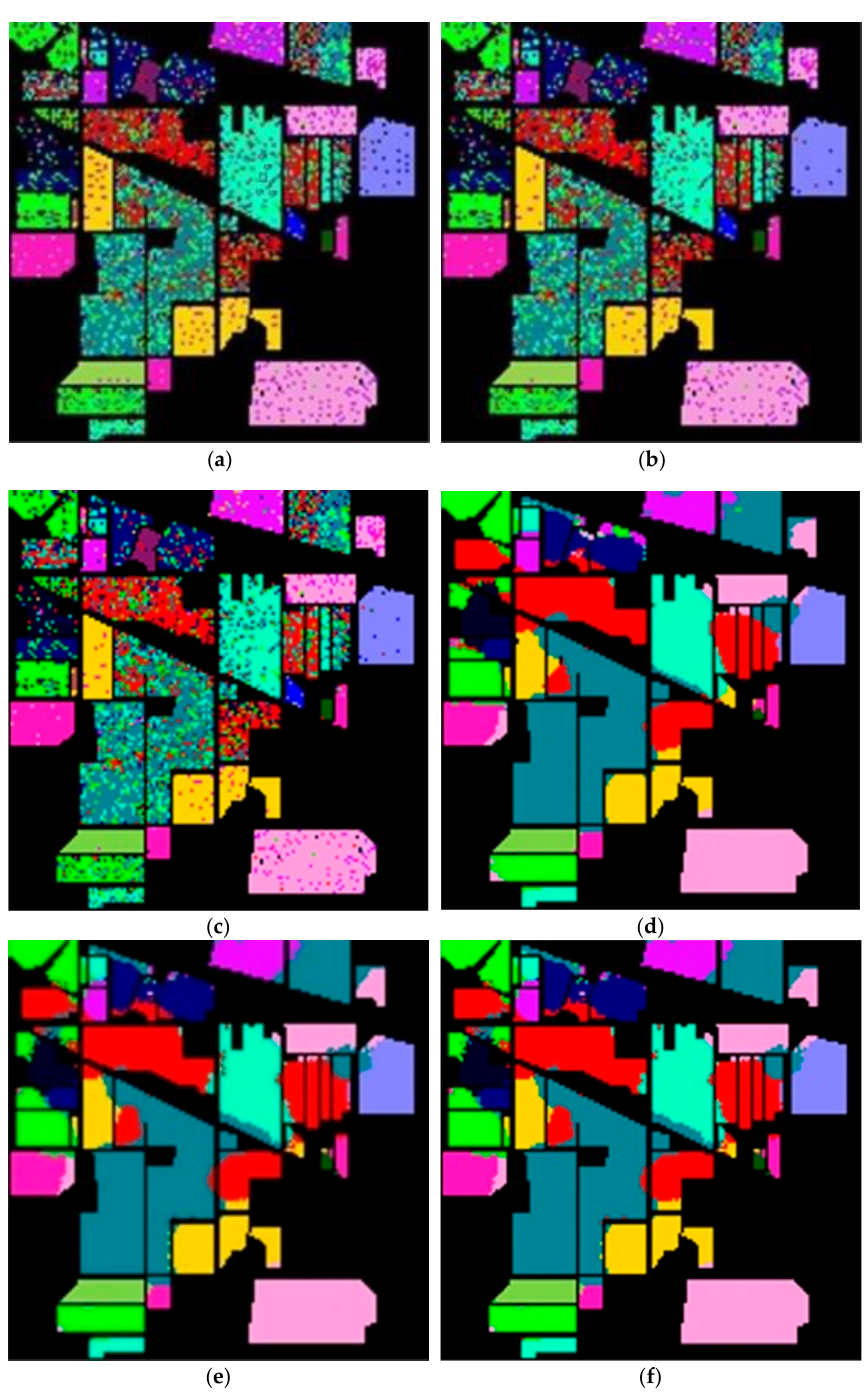
Figure 11. The classification label maps of dataset IPS. ( a ) (PCA, NN) ( b ) (PCA + FLE, NN), ( c ) (PCA + SVMFLE, NN), ( d ) (PCA, GAN), ( e ) (PCA + FLE, GAN), and ( f ) (PCA + SVMFLE, GAN). The proposed SVMFLE with the GAN classifier method was employed in HSI clas ‐ sification. The SVMFLE algorithm applies the SVM selected samples to improve the rep ‐ resentation of the between ‐ scatter matrix, which could extract much more useful discrim ‐ ination information. Accordingly, it obtained a better overall accuracy (OA) than that of Zhu’s method to the improvements of 3.5%, 1.7%, and 0.4% for the Salinas, Pavia Univer ‐ sity, and Indian Pines Site datasets, respectively. In the meanwhile, the proposed SVMFLE with the GAN classifier also obtained a better average accuracy (AA) than that of Zhu’s method to the improvements of 2.3%, 3.1%, and 0.7% for these three datasets, respectively. Owing to the fact that dataset IPS greatly varies in the pixel numbers of each class, a biased classifier is easily trained due to the biased training samples. The proposed SVMFLE with the GAN classifier method outperforms Zhu’s method only above 0.4% in OA. On the other hand, the pixel numbers of each class in dataset Salinas are large enough, the trained SVMFLE with the GAN classifier outperforms that of Zhu’s method above 3.5% in OA. Therefore, when the training samples are large enough and unbiased, the proposed method can obtain a powerfully discriminant feature space and significantly improve the classification performance. Otherwise, the improvement is limited if the training samples are few and biased. Finally, Figures 12 and 13 show the overall accuracy versus the reduced dimension ‐ ality in NN and GAN classifiers, respectively. From the results in Figures 12 and 13, the